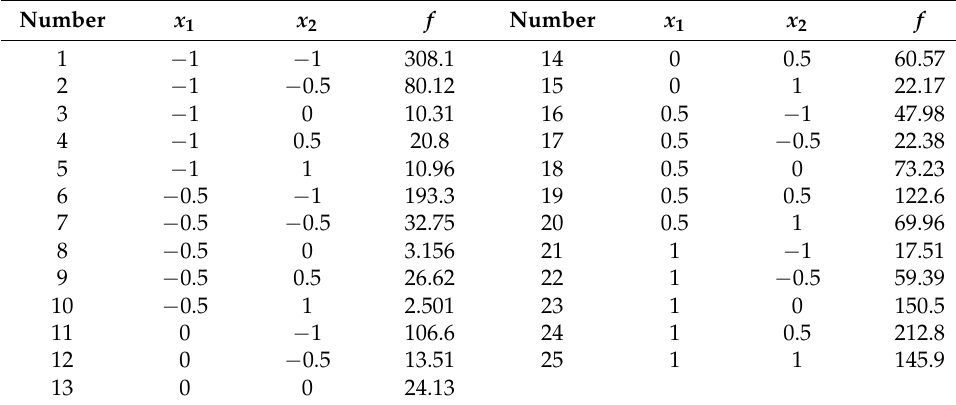
Table 1. The full factorial experimental design based on 2 level.